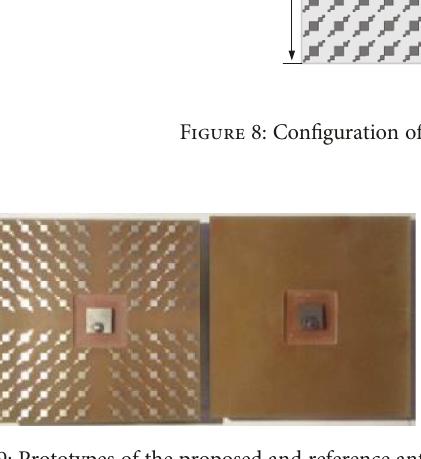
Figure 9: Prototypes of the proposed and reference antennas.